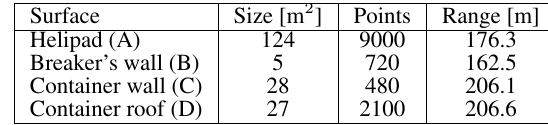
Table 2. Reference surfaces with labels as in Figure 2 in brackets, average size, average number of points and average distance to the laser scanner